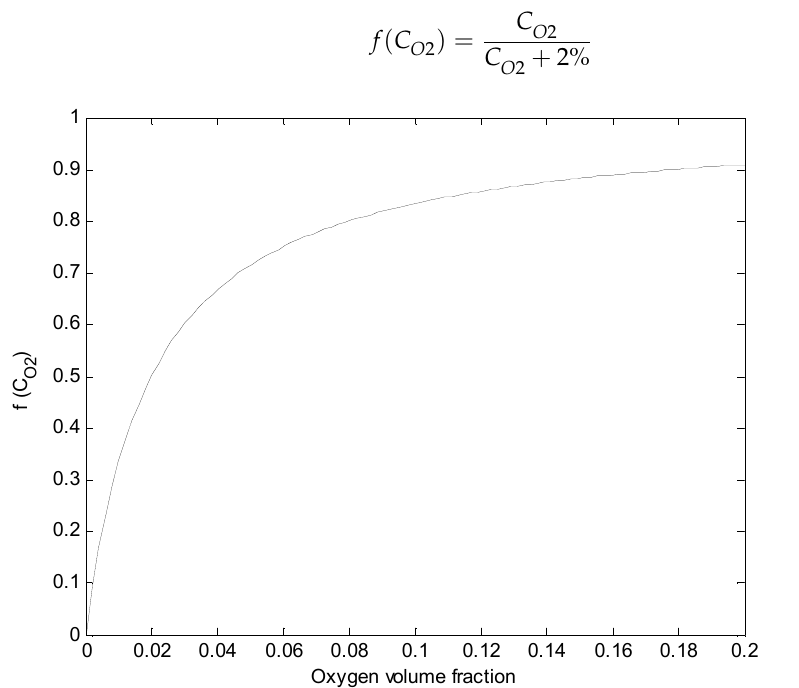
Figure 3. Oxygen concentration influence factor change with oxygen concentration.